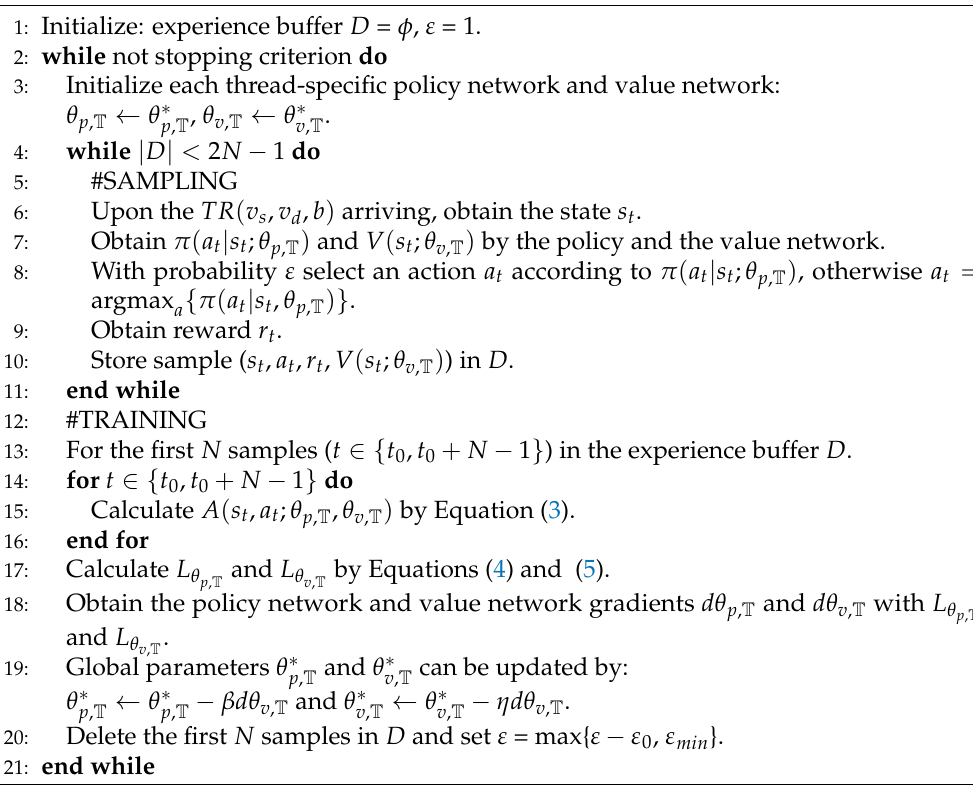
Algorithm 1 Training algorithm of the teacher